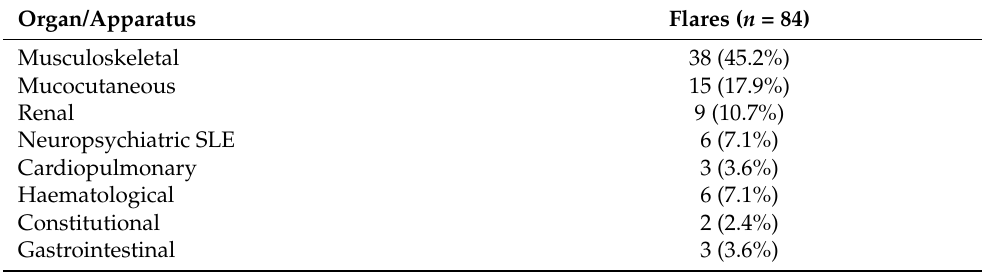
Figure 1. Flare-free estimates in long-term SLE patients up to 10 years from the 20th year of disease. Table 3. Clinical features of patients with flares after 20 years of follow up by BILAG domain.